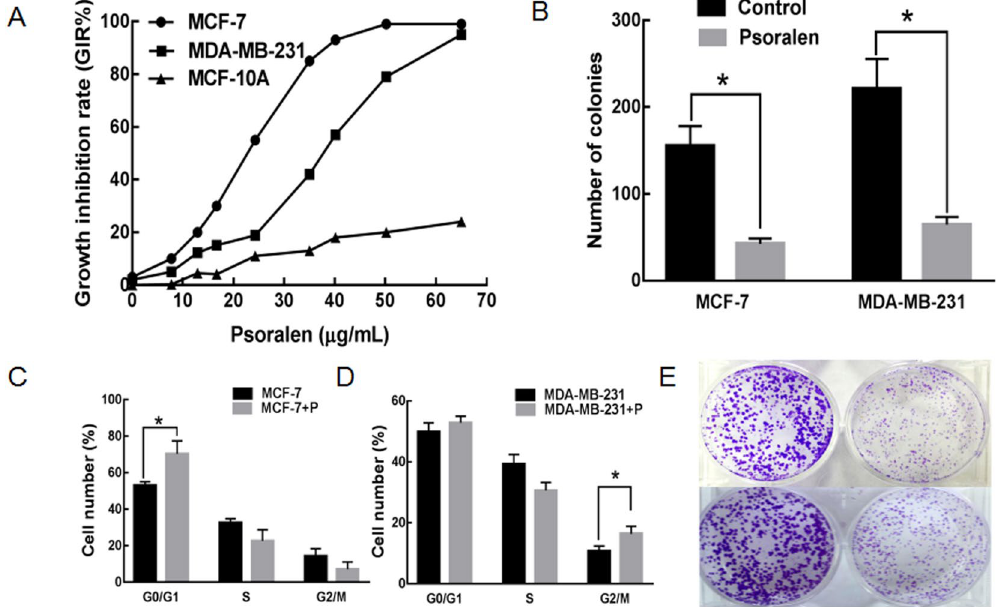
Figure 1. Effects of psoralen on the cytotoxicity and proliferation of breast cancer cell lines. ( A) MTT assay was performed after MCF-7 and MDA-MB-231 cells were treated with psoralen for 48 h. ( B ) Cells were treated with psoralen for 24 h and then the colony-formation ability was investigated after culturing at 37 °C and 5% CO 2 for 14 days. The pictures of colonies in a 6-wall dish were taken with phase contrast microscopy ( E ). The colony formation number was shown in ( B ). Flow cytometry results showed that psoralen induced G0/G1 phase cell cycle arrest in MCF-7 cells ( C ) and G2/M phase cell cycle arrest in MDA-MB-231 cells ( D ) ( * p <